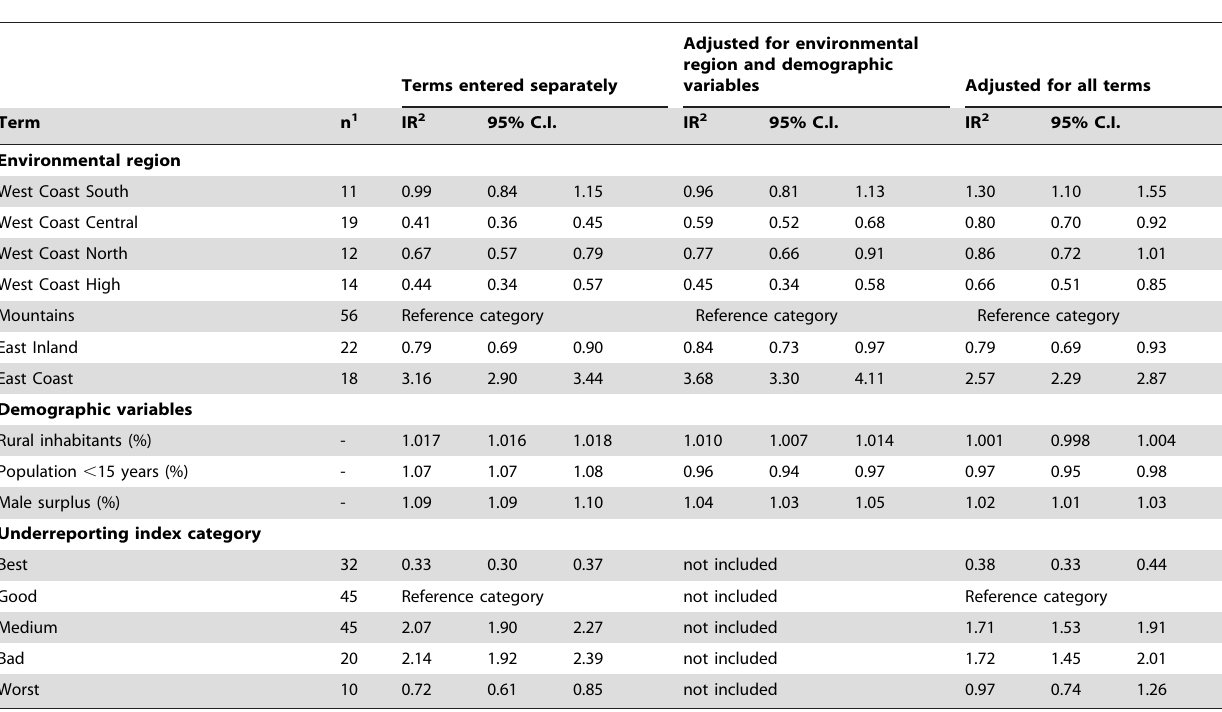
Table 2. Snakebite incidence ratios of environmental regions, demographic variables and underreporting index categories in Poisson regression